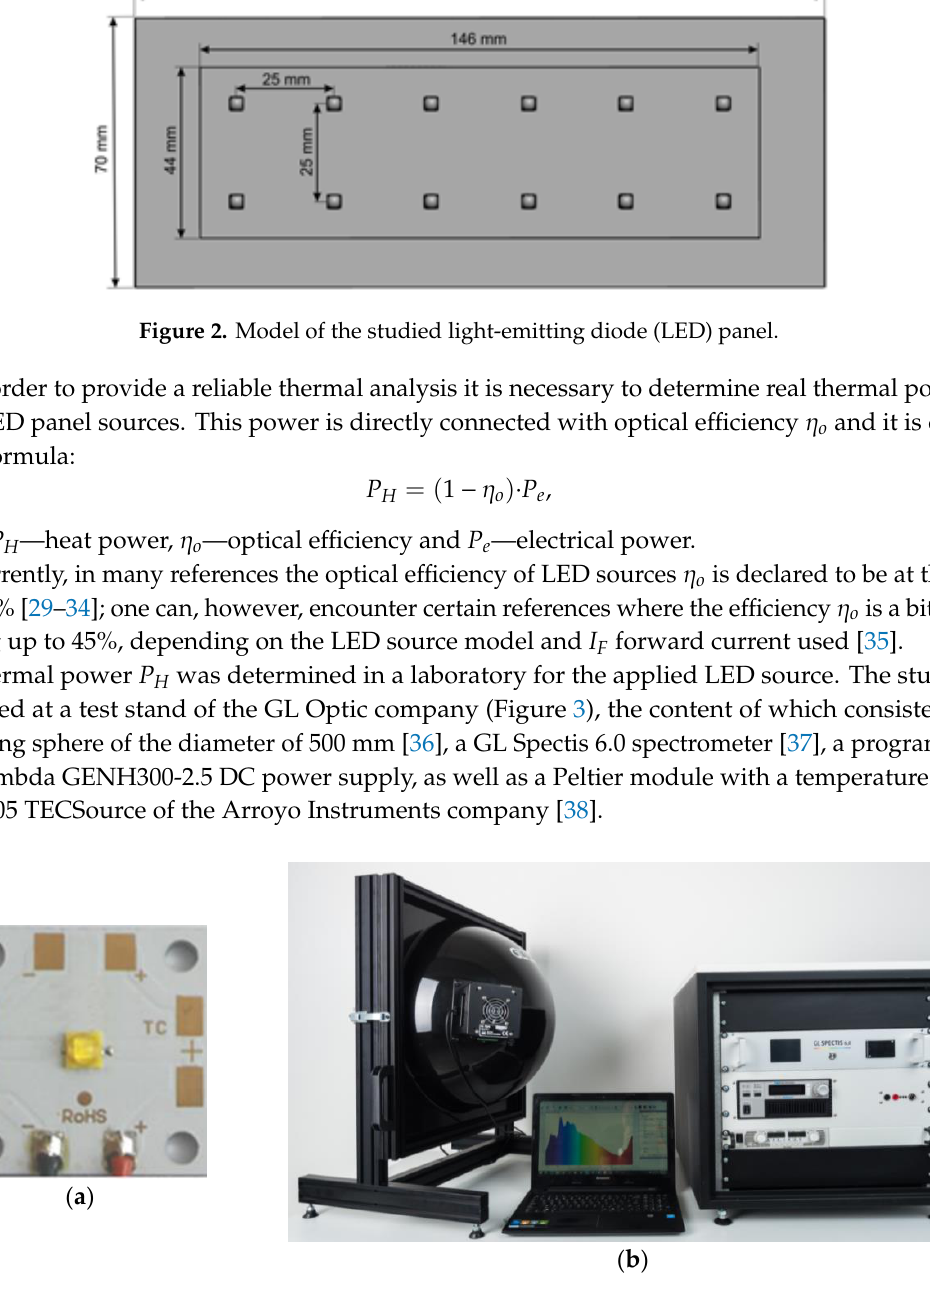
Figure 3. The studied LED source ( a ) and test stand of the GL Optic company ( b ) [36,37].